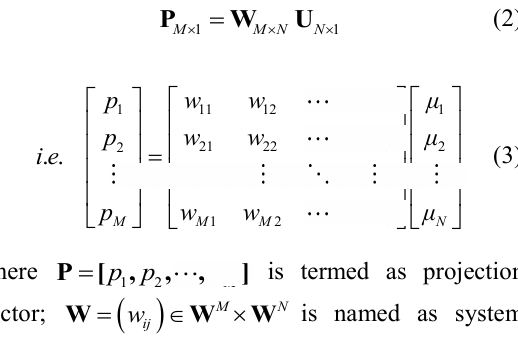
Fig. 2. Energy spectrum at 1.8m far away from the target (without moderator).